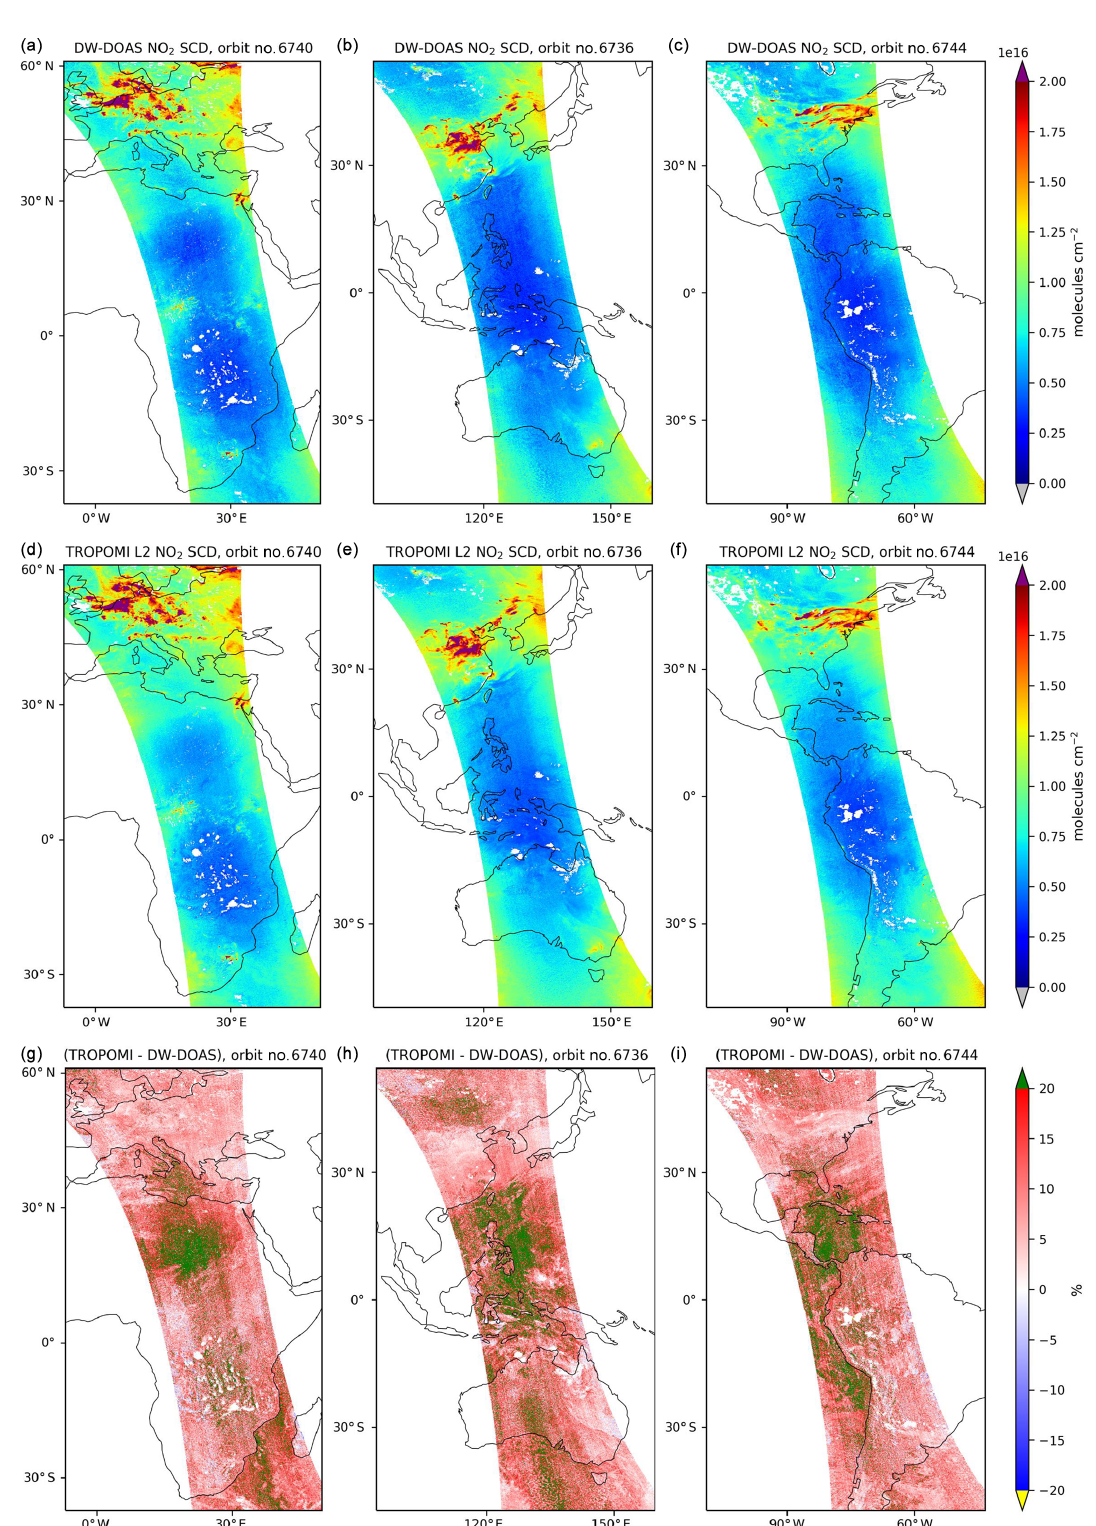
Figure 7. (a, b, c) NO 2 SCDs retrieved by DW-DOAS for selected orbits of 31 January 2019, (d, e, f) corresponding TROPOMI NO 2 SCDs, and (g, h, i) the relative differences between them calculated as (TROPOMI – DW-DOAS)/TROPOMI and expressed in percentage. All the data are screened using the quality assurance flag (qa > 0 . 5) from the TROPOMI NO 2 level 2 dataset, which includes all-sky